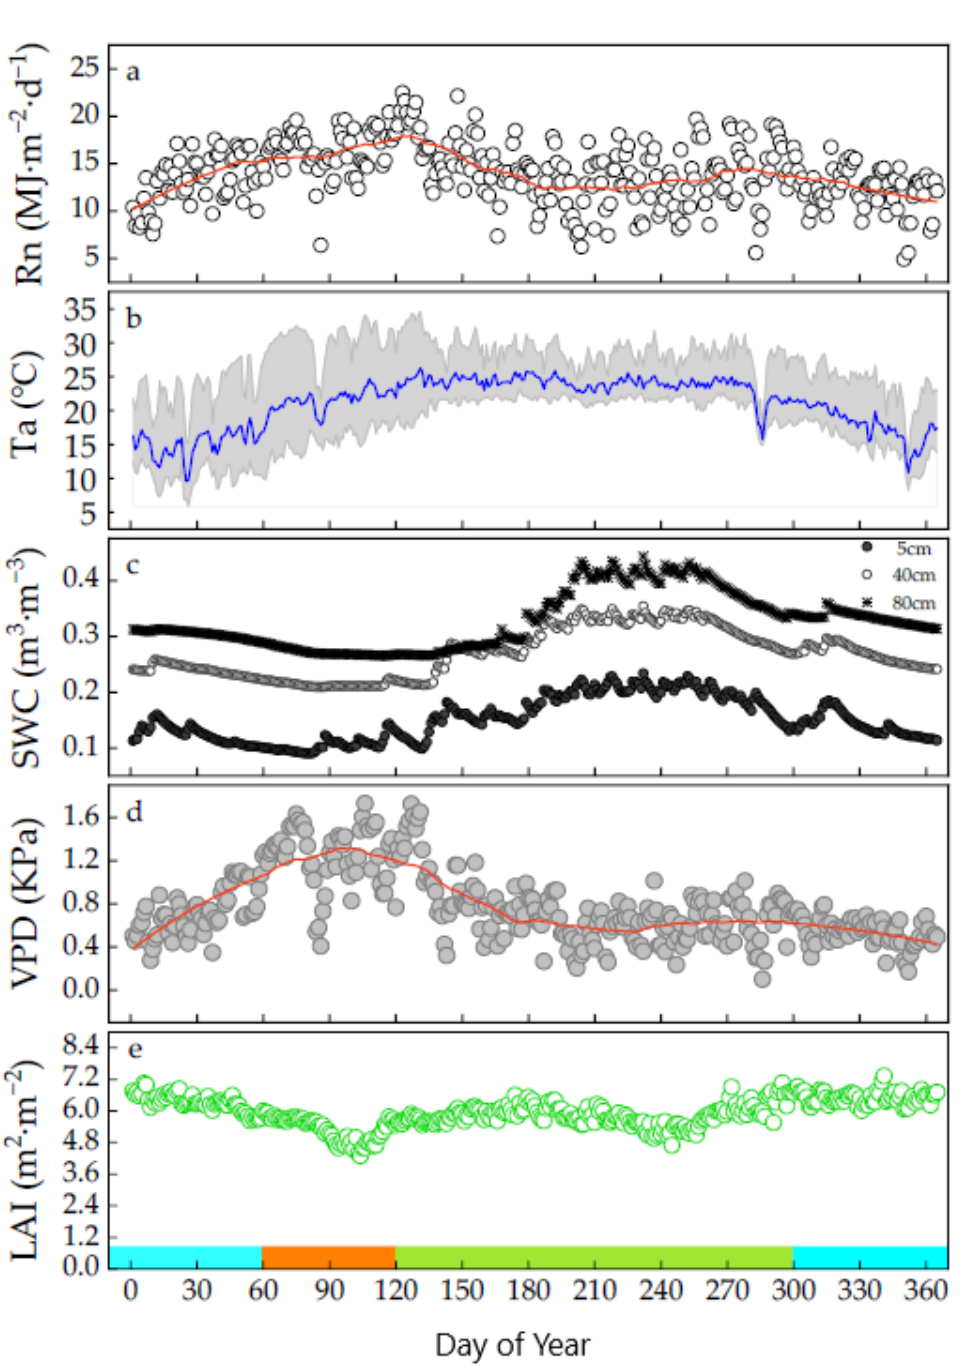
Figure 2. Meteorological conditions during the study period, ( a ) net radiation Rn; ( b ) air temperature Ta, shaded area is the difference between the maximum and minimum values; ( c ) soil water content SWC; ( d ) vapor pressure deficit VPD; ( e ) leaf area index LAI, where lake blue indicates the foggy-cool season, orange indicates the hot-dry season, and green is the rainy season. Notably, VPD and SWC displayed the opposite strong seasonal variation (Figure